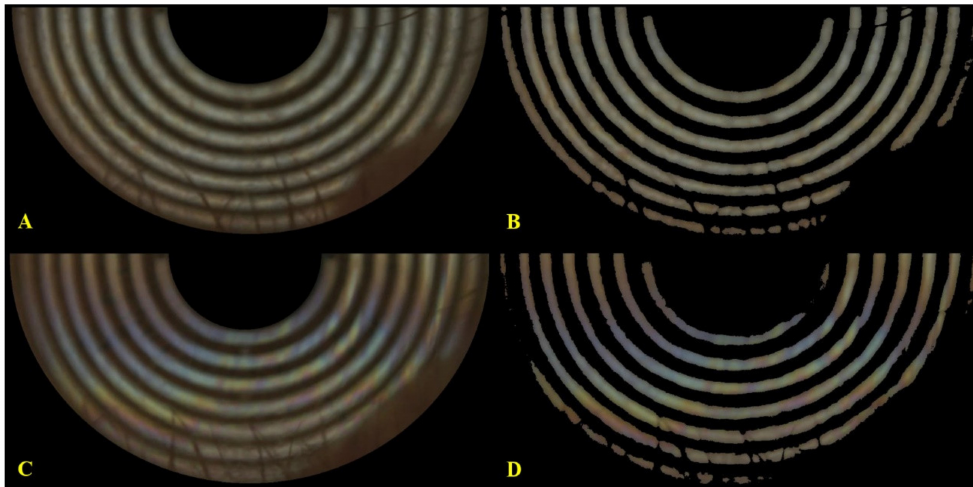
Figure 3. The pre- and post-segmentation interference lipid tear film images of the right eyes of two subjects. ( A , C ) the lipid tear image of patient no. 1 and 2, respectively, before the segmentation processing; ( B , D ) the lipid tear image of patient no. 1 and 2, respectively, after the image segmentation processing. All images showed shadows of eyelashes and inferior medial eyelid over the inferior area. Comparing pre- and post-segmentation images for the same subject, the bright ring showed a thinner width and were trimmed at some blurred area after segmentation. Furthermore, the post-segmented image showed clearer and sharper presentation than the pre-segmented